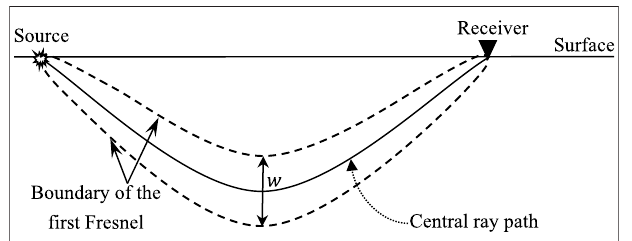
FIGURE 5 | Schematic illustration of the fi rst Fresnel zone for one source – receiver pair. w indicates the width of the fi rst Fresnel zone.